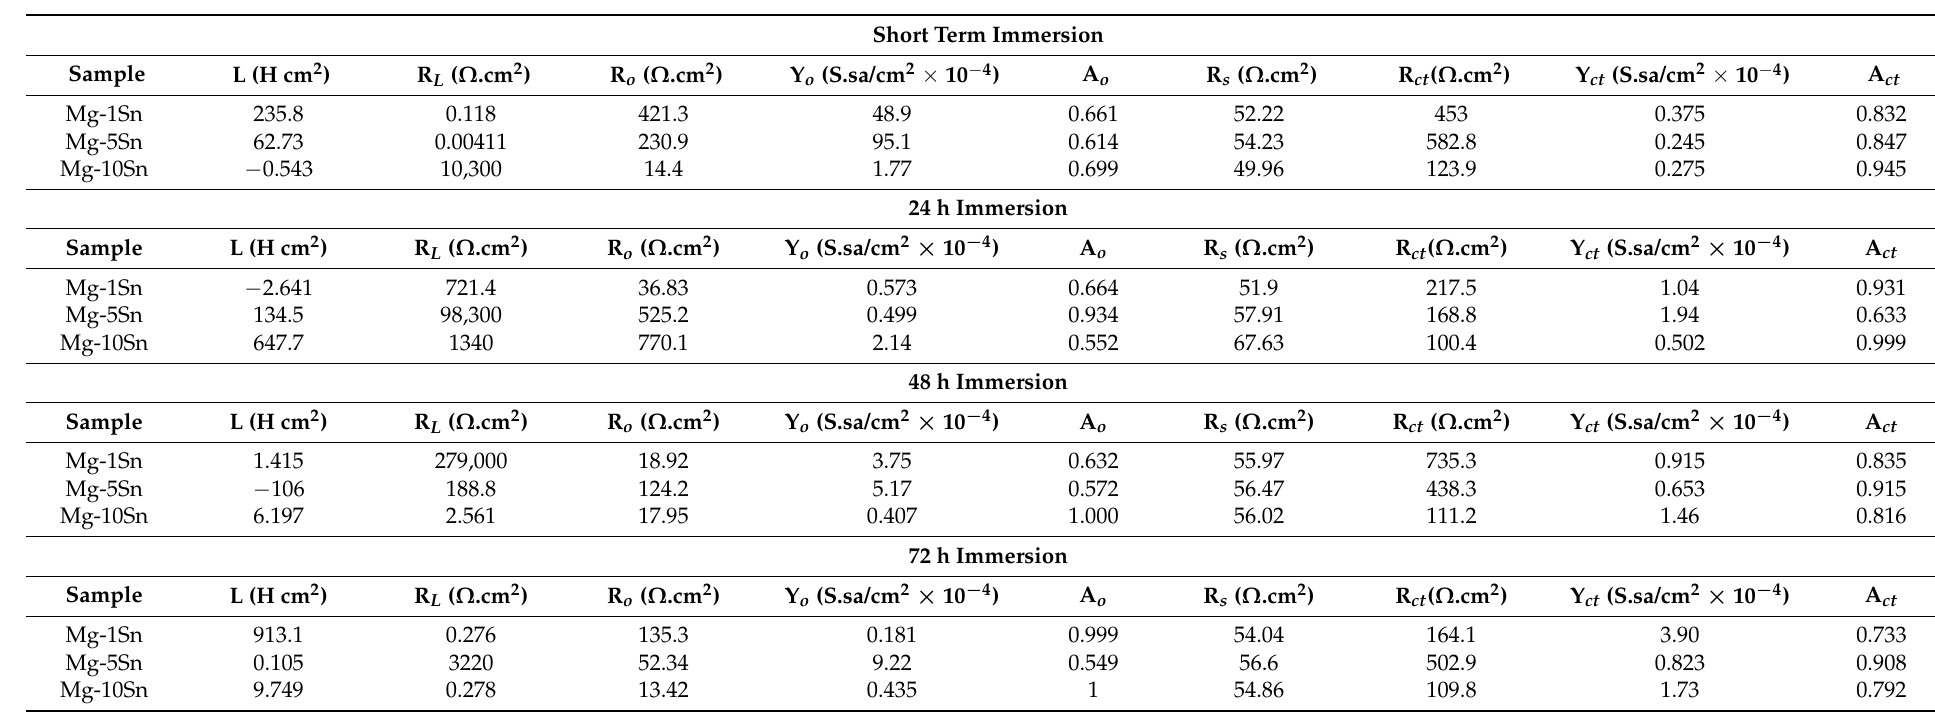
Table 4. Electrochemical data obtained by equivalent circuit fitting of EIS curves of Mg-Sn